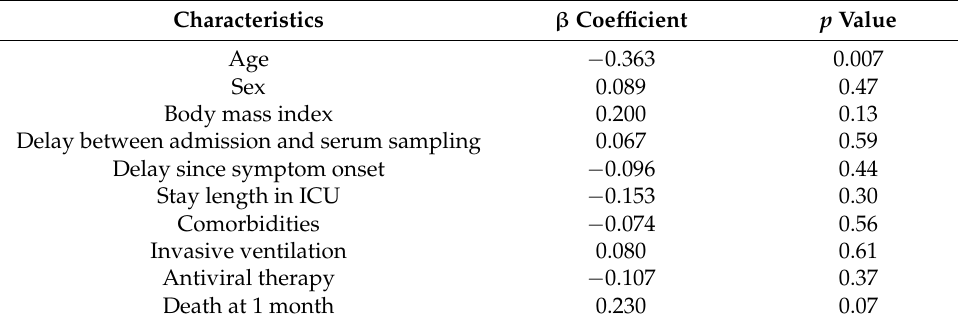
Table 2. Factors associated with IFN α levels in ICU patients (linear